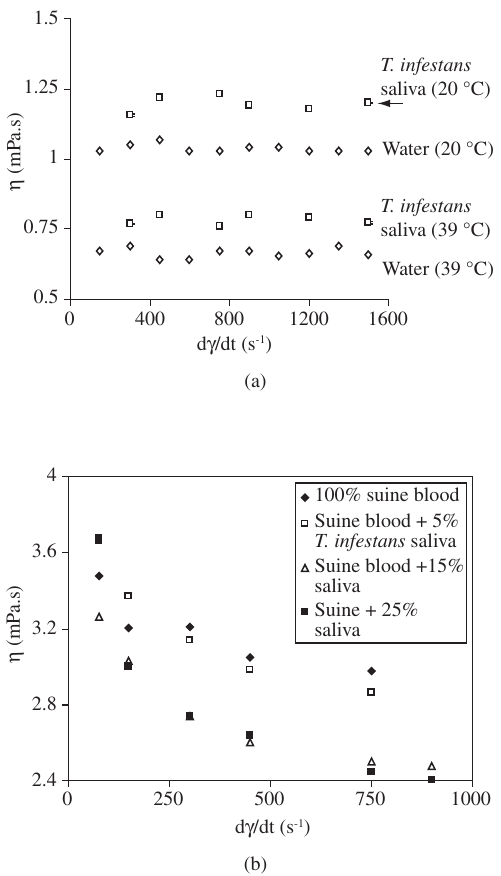
Figure 2. a) Viscosity of the T. infestans saliva at 20 °C and 39 °C; and b) Viscosity of pig blood with addition of T. infestans saliva.